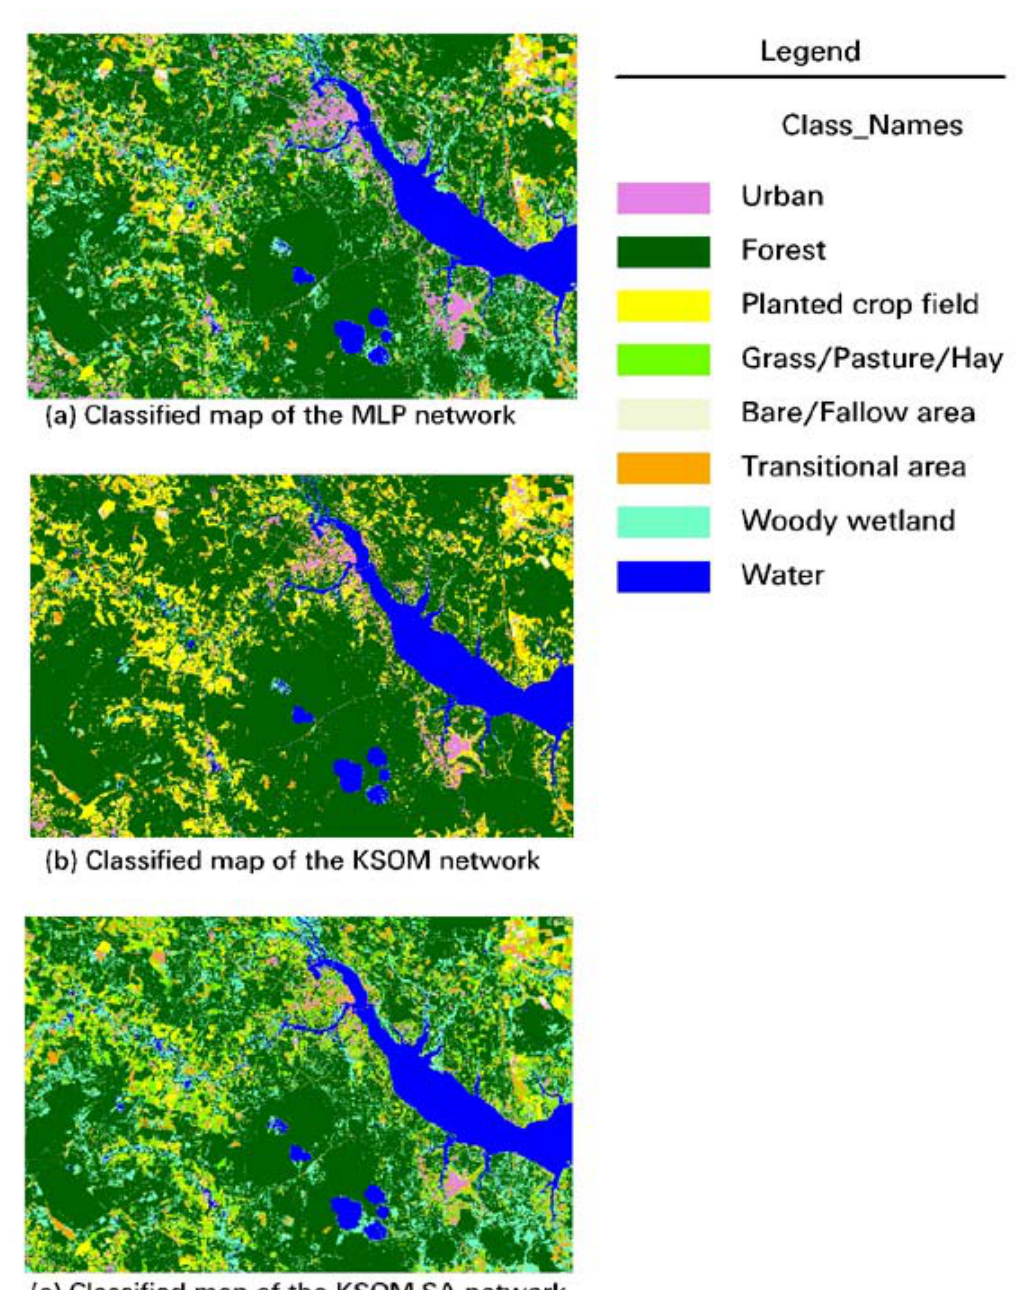
Figure 6. Classified maps of the three network